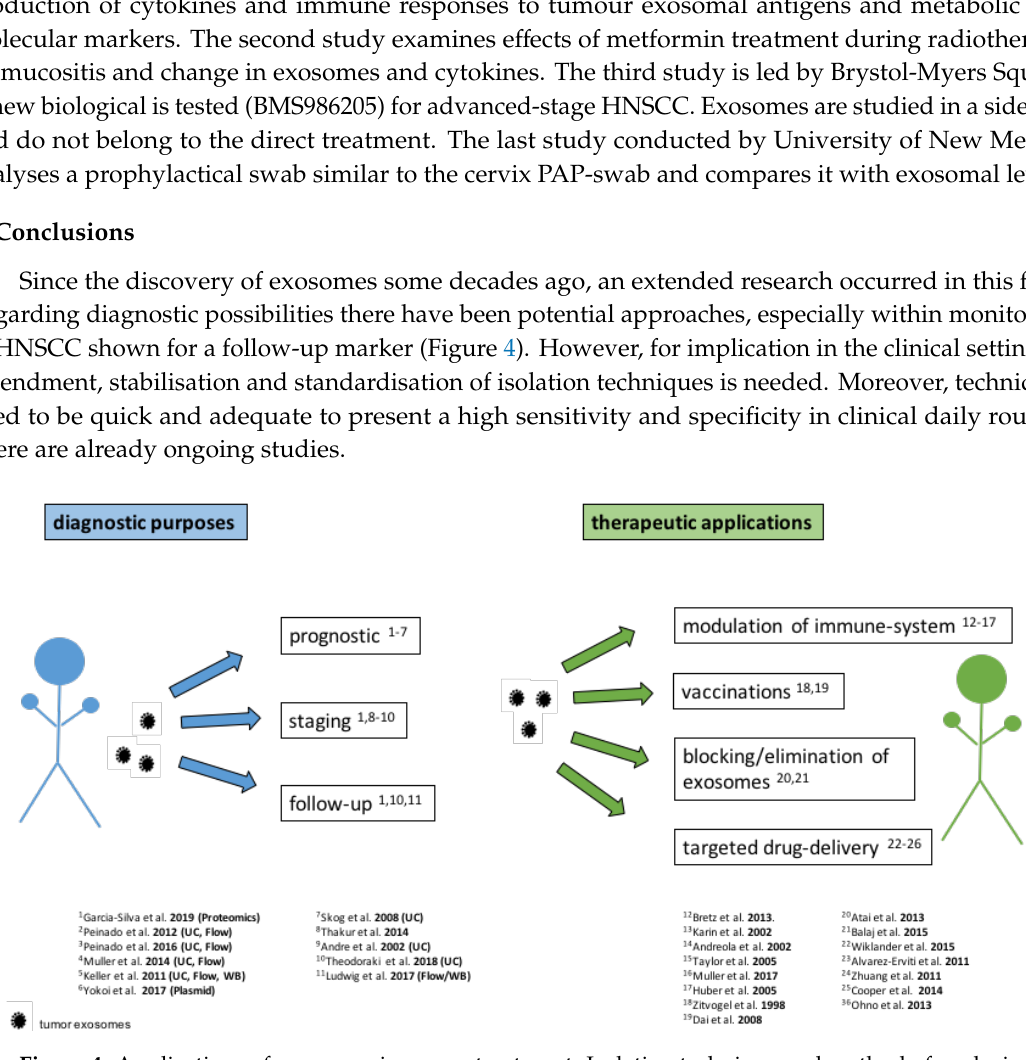
Figure 4. Applications of exosomes in cancer treatment. Isolation technique and method of analysis are written in brackets for the diagnostic purposes. Most research groups used size exclusion chromatography with ultracentrifugation (UC) or flow cytometry (Flow). Some used Western blotting (WB), plasmid transfection (Plasmid) or Fluorescence Activated Cell Sorting (FACS). List of papers consists of a